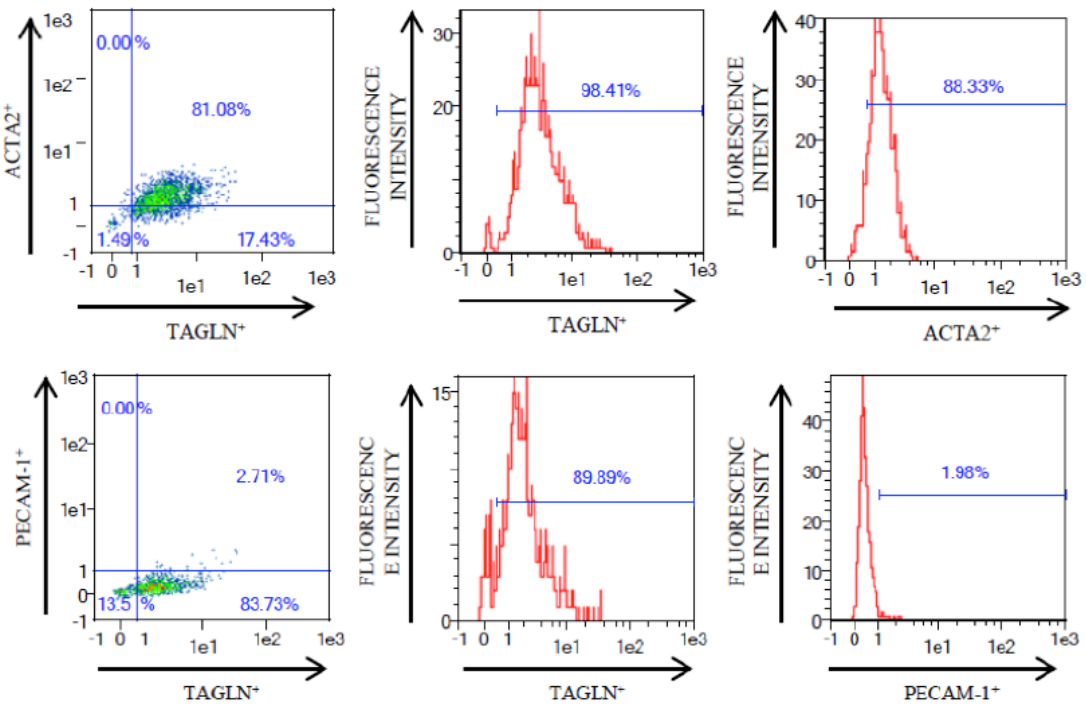
Figure 2. Illustrative graphs of flow cytometry of VSMCs isolated from human atherosclerotic carotid artery. ACTA2 and TAGLN were positive markers of VSMCs while PECAM-1 was negative for these cells.